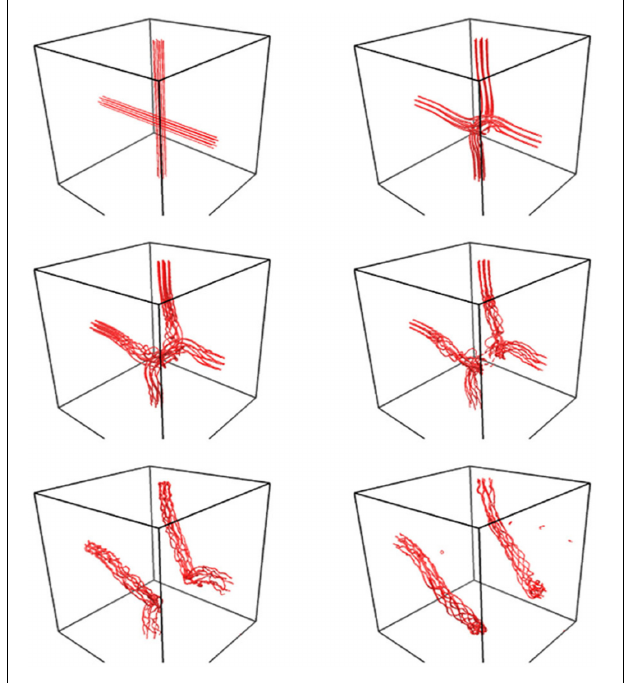
FIGURE 4 | Numerical simulations of reconnecting vortex filament bundles in superfluid obtained by solving the Gross-Pitaevskii equation. Reprinted figure with permission from Alamri et al. [71]. Copyright (2008) by the American Physical